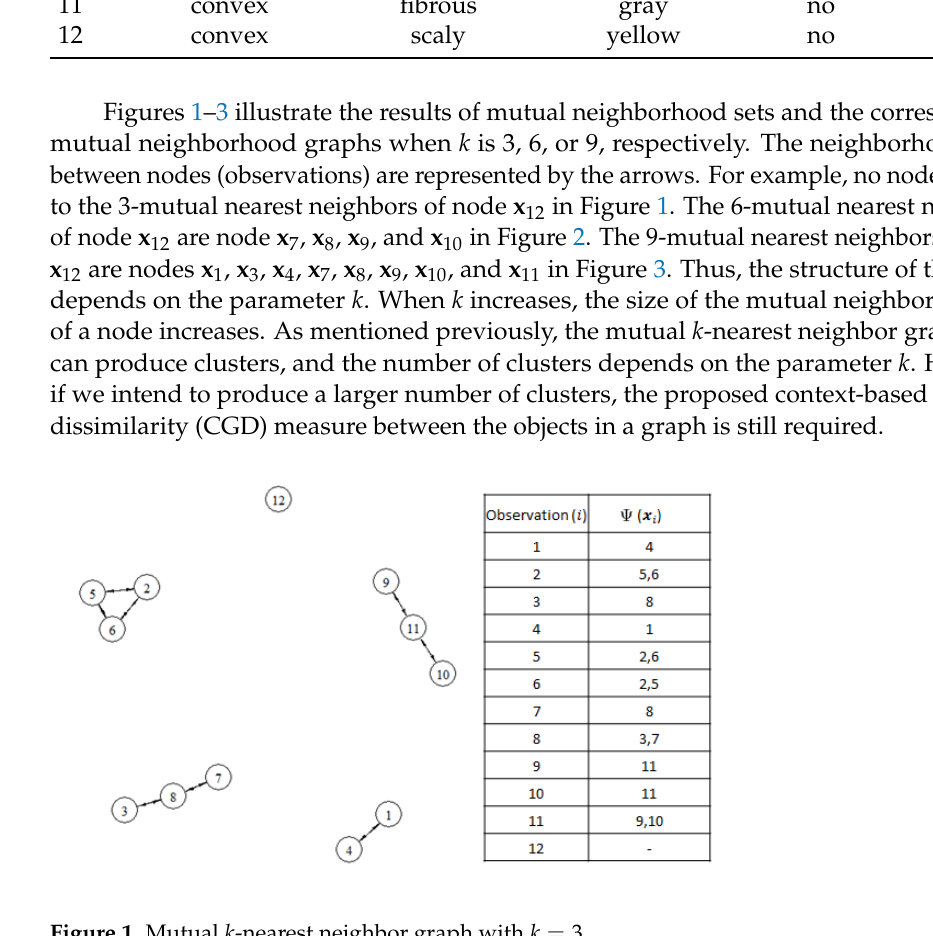
Figure 1. Mutual k -nearest neighbor graph with k =